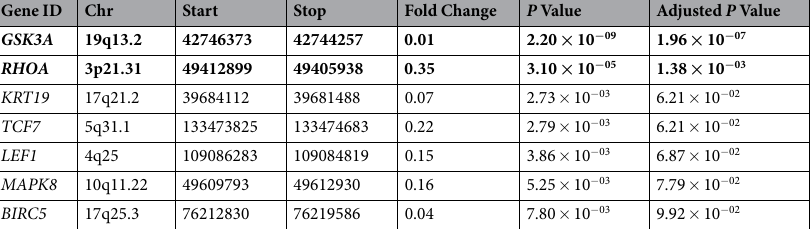
Table 2. Differential expressed genes analyzed by DESeq. 2 (Colorectal adenoma vs. Normal